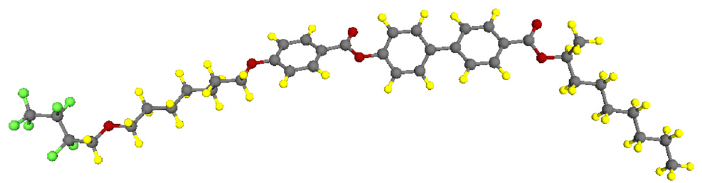
Figure 1. The general structure of (S)-4 ′ -(1-methyloctyloxycarbonyl) biphenyl-4-yl 4-[7-(2,2,3,3,4,4,4-heptafluorobutoxy) heptyl-1-oxy]-benzoate (3F7HPhH7), where C-atoms are marked by dark gray, H-atoms by yellow, O-atoms by red and F-atoms by light green.